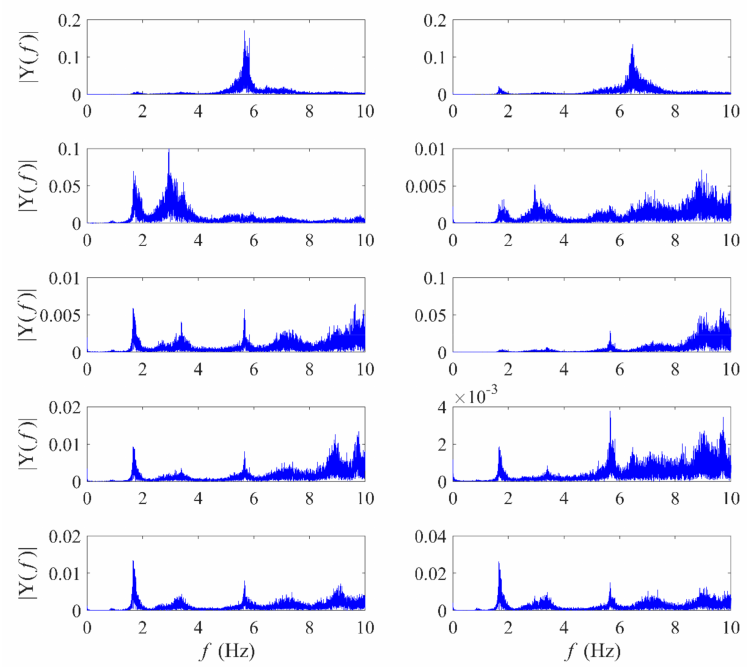
Figure 7. Fourier spectra of the modal responses, obtained from SOBI using test